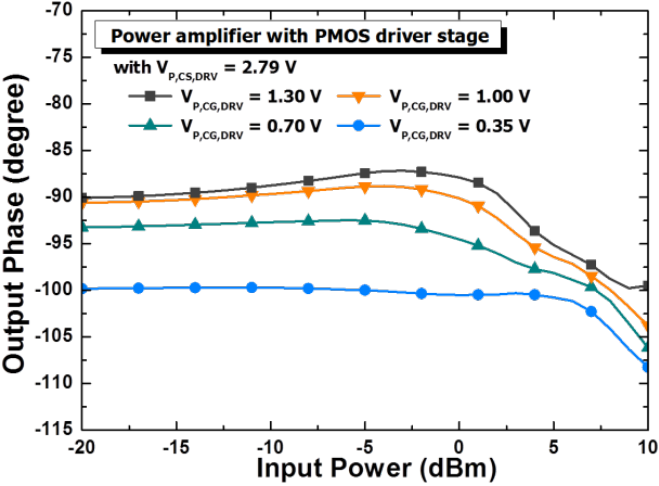
Figure 13. Simulated output phase of the proposed PA with PMOS driver stage (V DD = 3.3 V).